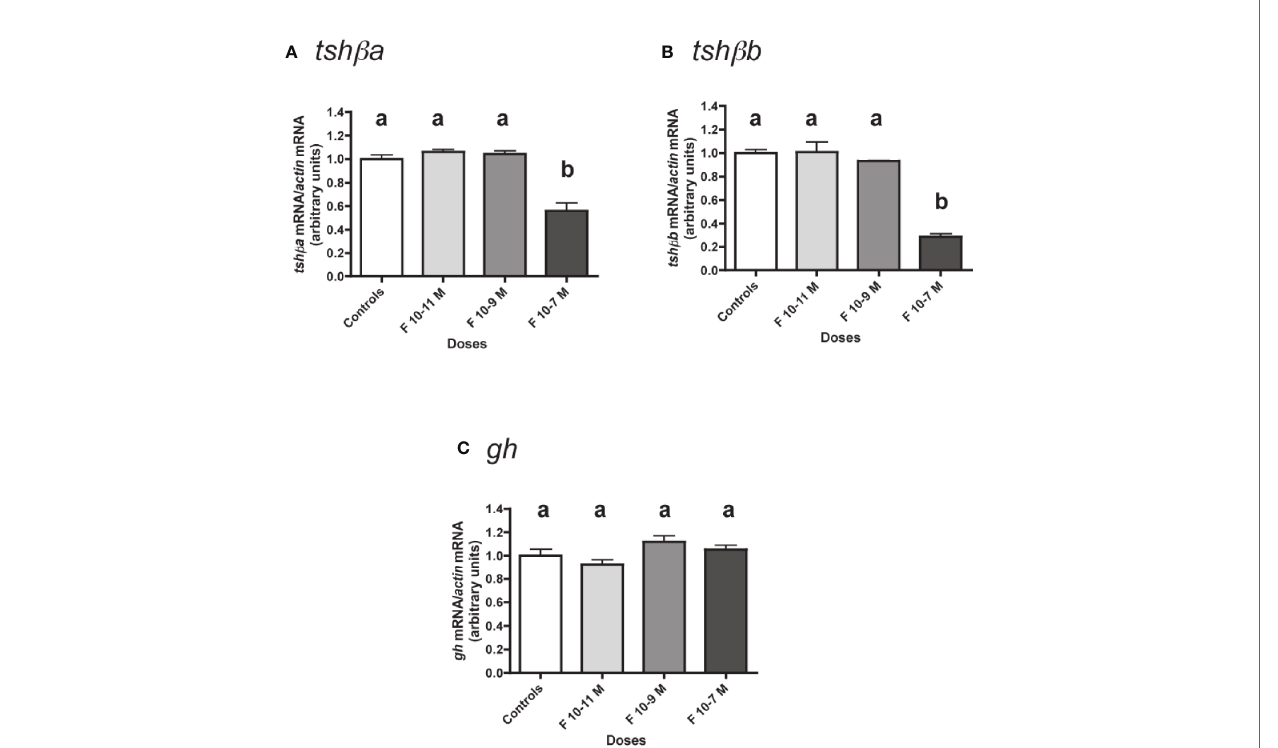
FIGURE 2 | Effects of cortisol (F) on the expression of tsh b a , tsh b b , and gh transcript levels in primary cultures of Atlantic salmon pituitary cells. Pituitary cells from juvenile Atlantic salmons were treated with various concentrations of F for 10 days. The mRNA levels of tsh b a (A) , tsh b b (B) , and gh (C) were quanti fi ed by qPCR. Data were normalized against b -actin . The Figure displays the results from a representative experiment of three independent cell culture experiments. Mean ± SEM; n = 5 well replicates. Different letters indicate signi fi cant differences,